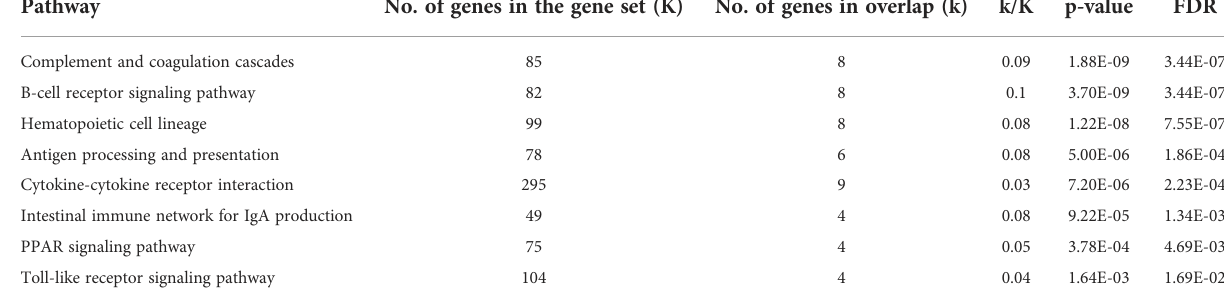
TABLE 1 Pathway analysis of the DEGs between human myocardial B-cells and human peripheral blood B-cells from publicly available datasets. Pathway No. of genes in the gene set (K)